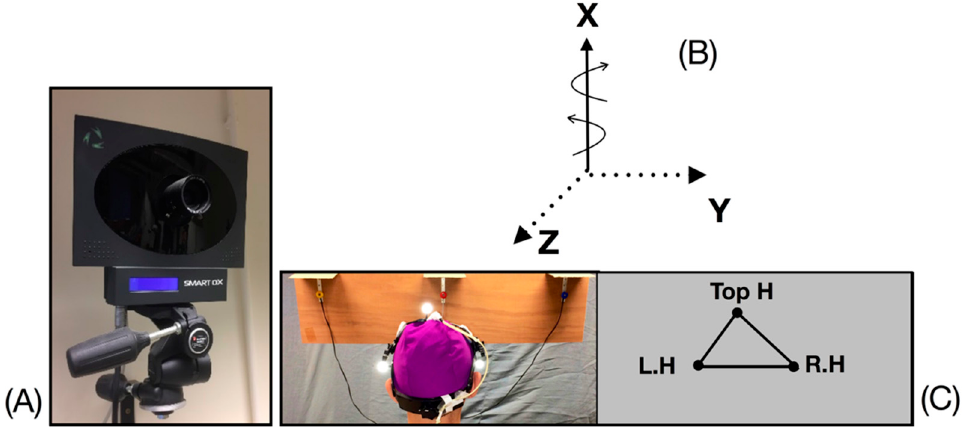
Figure 2. ( A ) Infra-red cameras (ELITE, BTS, Milan, Italy). ( B ) Head axis of rotation is denoted as X. ( C ) Placement of the reflective markers on the head. ( C ) Placement of the reflective markers on the